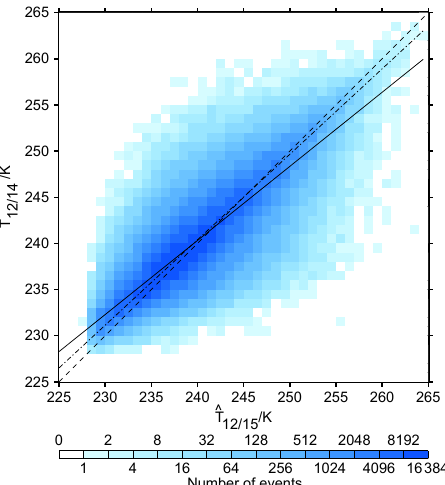
Figure 9. 2-D histogram of brightness temperatures, displaying ˆ T 12 / 15 on the abscissa and T 12 / 14 on the ordinate axes. The data are from 1004 common days of operation of NOAA 14 and NOAA 15. The dashed diagonal line represents x = y , the solid line is the best fit according to an ordinary least squares regression and the dashed– dotted line is the bivariate regression line.